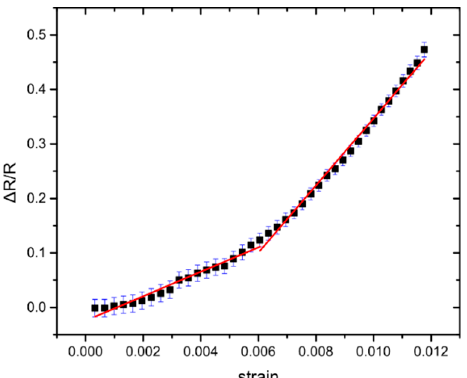
Figure 8. Relative resistance change over strain of a sensor after applying 1000 cycles of 1.2% strain. Error bars represent the standard deviation of the measurements. Our model predicts the sensor behaviour, using two linear slopes in order to fit the experiment results. The sensor has GF1~22 for lower strains and GF2~61 for higher strains.